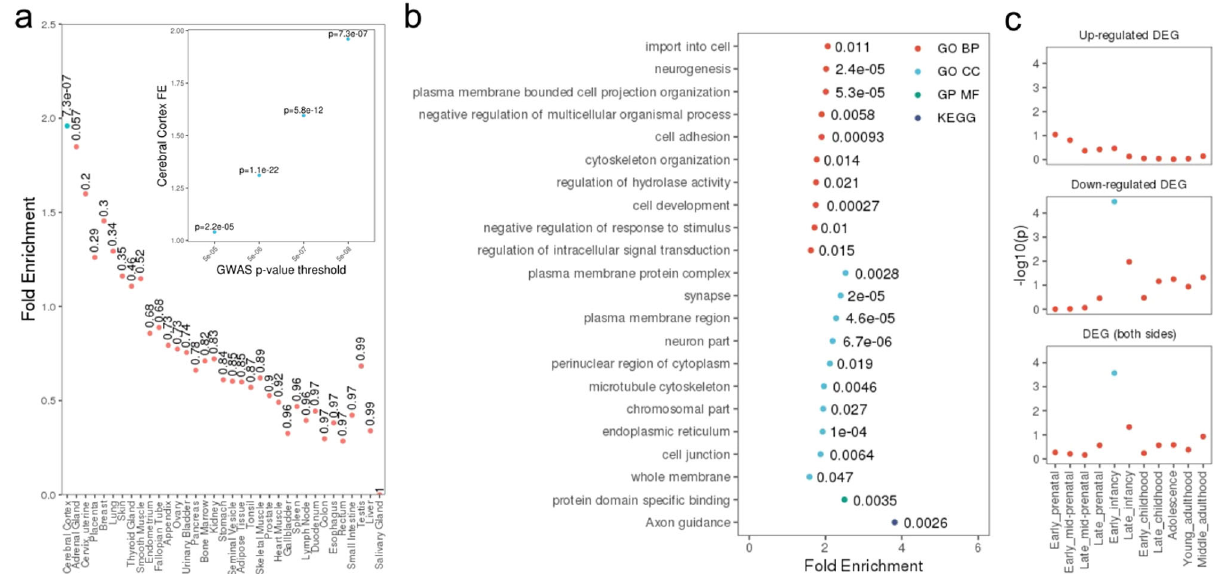
Fig. 2 | Enrichment of genes in signi fi cant loci for tissue expression, pathways and brain developmental stages. a Gene expression across various tissues (inset showssensitivity analysisatotherGWAS thresholds),blue pointsindicate multiple adjusted p <0.05.Hypergeometrictestusedtoderive p -values(uncorrected). b GO